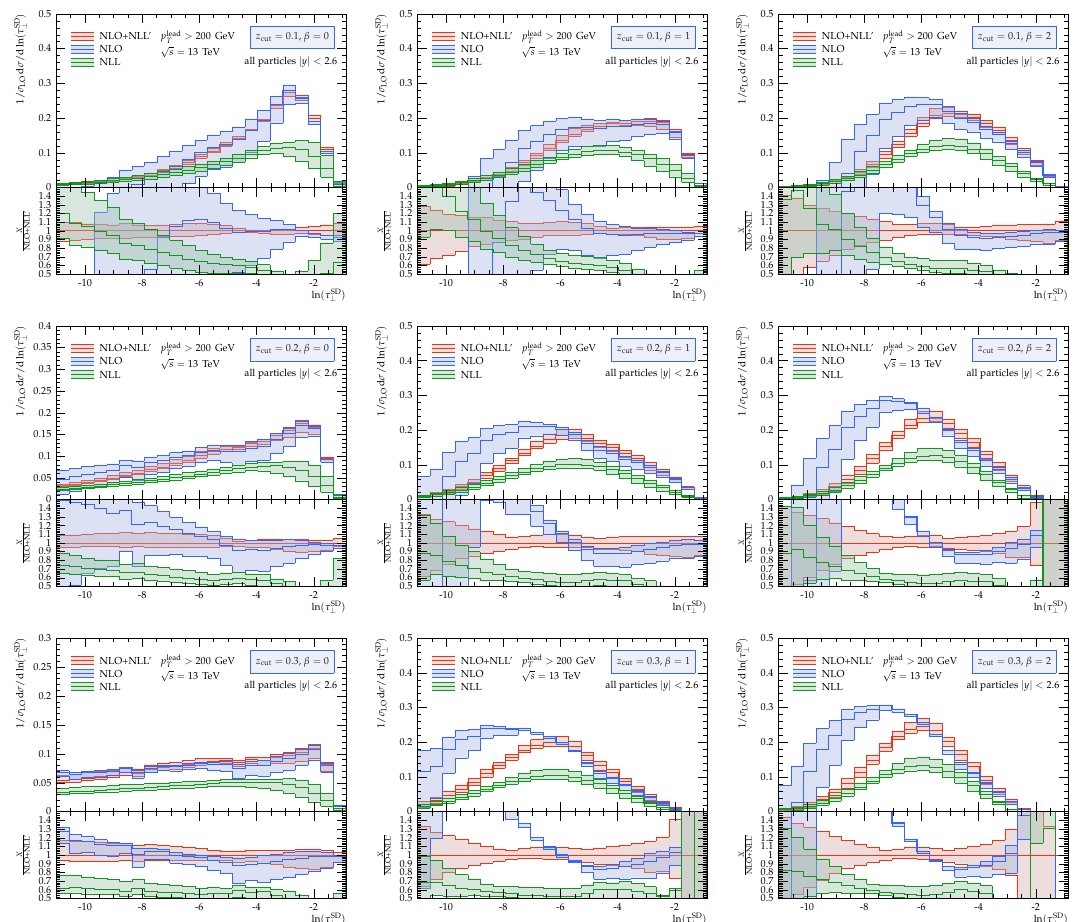
Figure 8 . NLO + NLL 0 predictions for groomed transverse thrust for β ∈ { 0 , 1 , 2 } (columns) and z cut ∈ { 0 . 1 , 0 . 2 , 0 . 3 } (rows) for the p T, min = 200 GeV event selection in comparison to the NLO result and the pure NLL